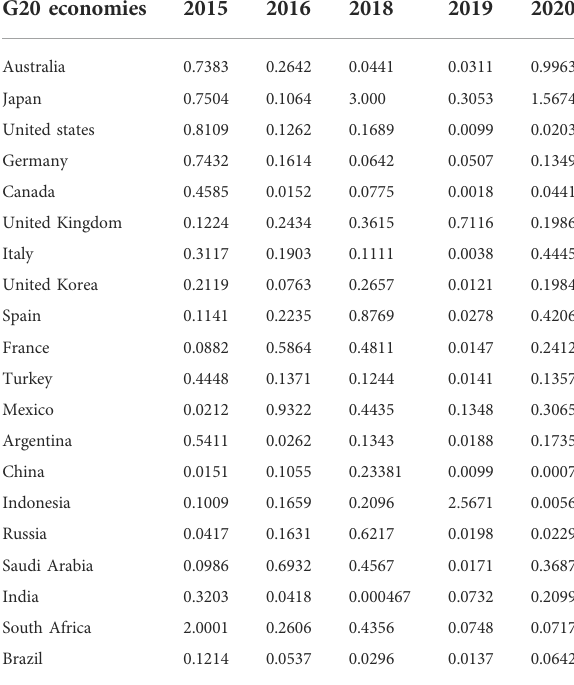
TABLE 1 Energy ef fi ciency